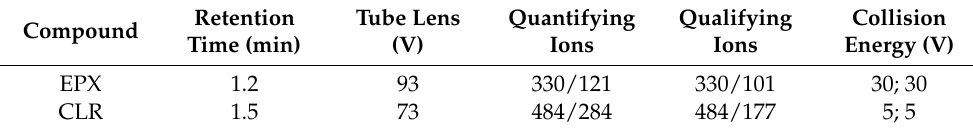
Table 2. HPLC-MS/MS parameters for EPX and